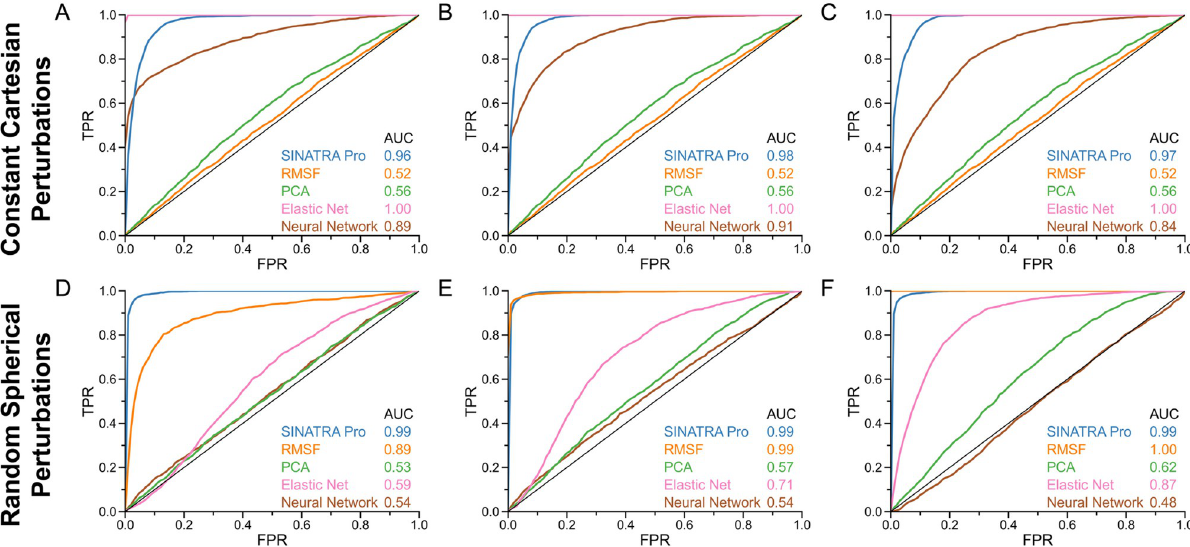
Fig 2. Receiver operating characteristic (ROC) curves comparing the power and robustness of SINATRA Pro to competing 3D mapping approaches in controlled molecular dynamic (MD) simulations. To generate data for these simulations, we consider two phenotypic classes using the real structural data of wild-type β -lactamase (TEM). In the first phenotypic class, structural protein data are drawn from equally spaced intervals over a 100 ns MD trajectory (e.g., t MD = [0, 1, 2, 3, ... , 99] ns + δ , where δ is a time offset parameter). In the second phenotypic class, proteins are drawn at 1 ns intervals shifted 0.5 ns with respect to the first set (e.g., t MD = [0.5, 1.5, 2.5, 3.5, ... , 99.5] ns + δ ) to introduce thermal noise, and then we displace the atomic positions of each atom in the O -loop region by (top row) a constant Cartesian vector of (A) 0.5 Å ngstro¨ms ( Å ), (B) 1.0 Å , and (C) 2.0 Å , or (bottom row) by a spherically uniform random vector of (D) 0.5 Å , (E) 1.0 Å , and (F) 2.0 Å . Altogether, we have a dataset of N = 1000 proteins per simulation scenario: 100 ns interval × 5 different choices δ = {0.0, 0.1, 0.2, 0.3, 0.4} ns × 2 phenotypic classes (original wild-type versus perturbed). The ROC curves and corresponding area under the curves (AUC) depict the ability of SINATRA Pro to identify “true class defining” atoms located within the O -loop region using parameters { r = 1.0 Å , c = 20, d = 8, θ = 0.80, l = 120} chosen via a grid search. We compare SINATRA Pro to four methods: root mean square fluctuation (RMSF) (orange); principal component analysis (PCA) (green); Elastic Net classification (pink); and a Neural Network (brown). For details on these approaches, see Materials and methods. A sensitivity analysis exploring the optimal parameter configurations for PCA and Neural Network can be found in Supporting Information (see S3 and S4 Figs,